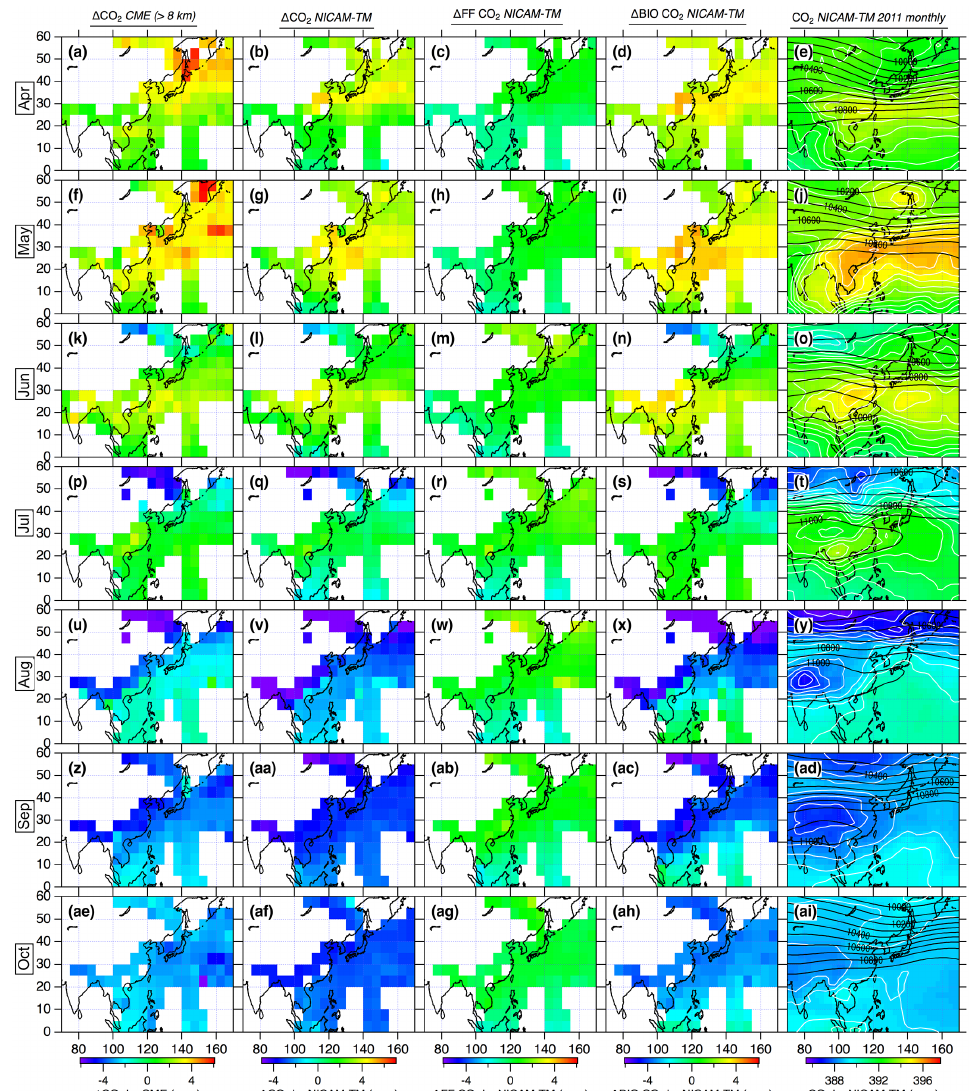
Figure 6. Comparison of the observed and simulated distributions of CO 2 in the UT. Column 1 shows (cid:49) CO 2 observed by CONTRAIL CME. Columns 2–4 show (cid:49) CO 2 , (cid:49) FF CO 2 , and (cid:49) BIO CO 2 simulated by NICAM-TM. The CONTRAIL data are simply averaged for each grid, and the NICAM-TM data are sampled at locations and times corresponding to the observation data and analyzed in the same manner. Also shown are the simulated monthly distributions of CO 2 at 250hPa pressure surface in 2011 (column 5). Solid lines in white and black in column 5 indicate CO 2 isolines and geopotential height at 250hPa pressure surface,